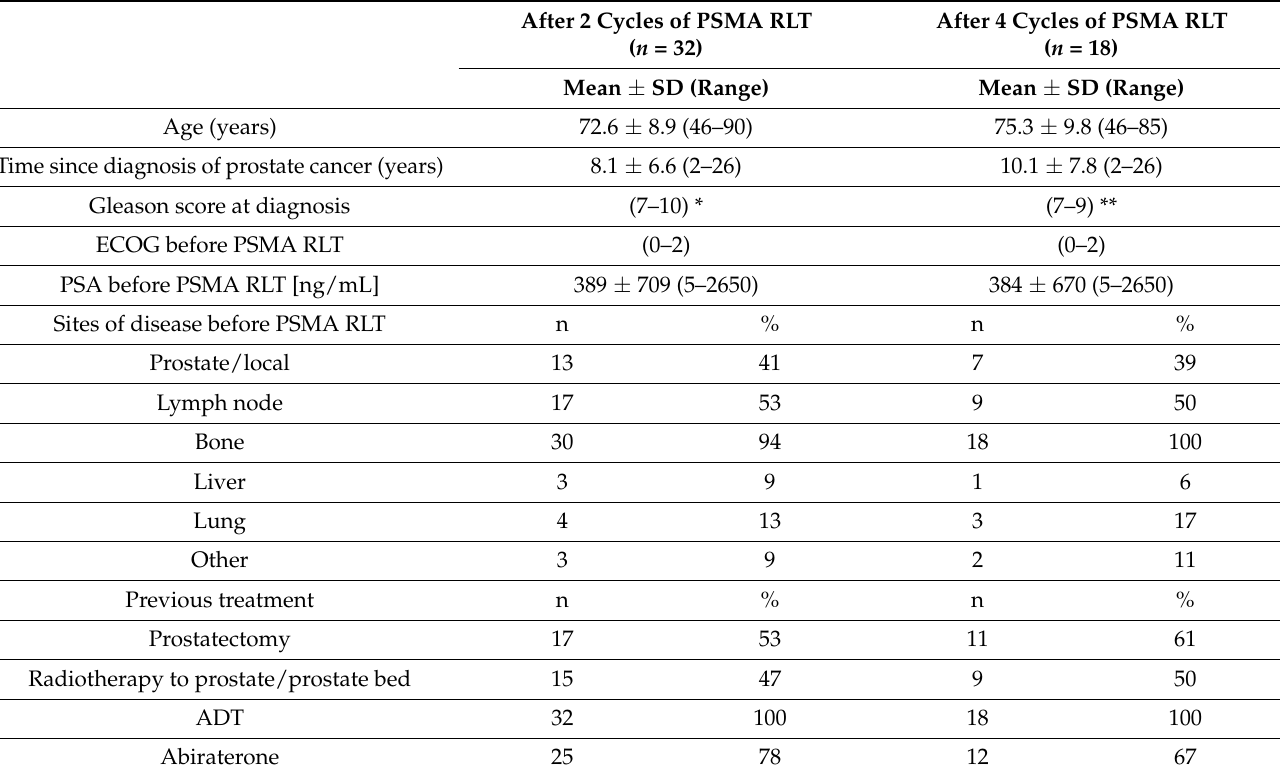
Figure 1. Flow diagram of patients included in this analysis undergoing PSMA radioligand therapy (RLT) and dual tracer PET/CT. Table 1. Patients’ characteristics.